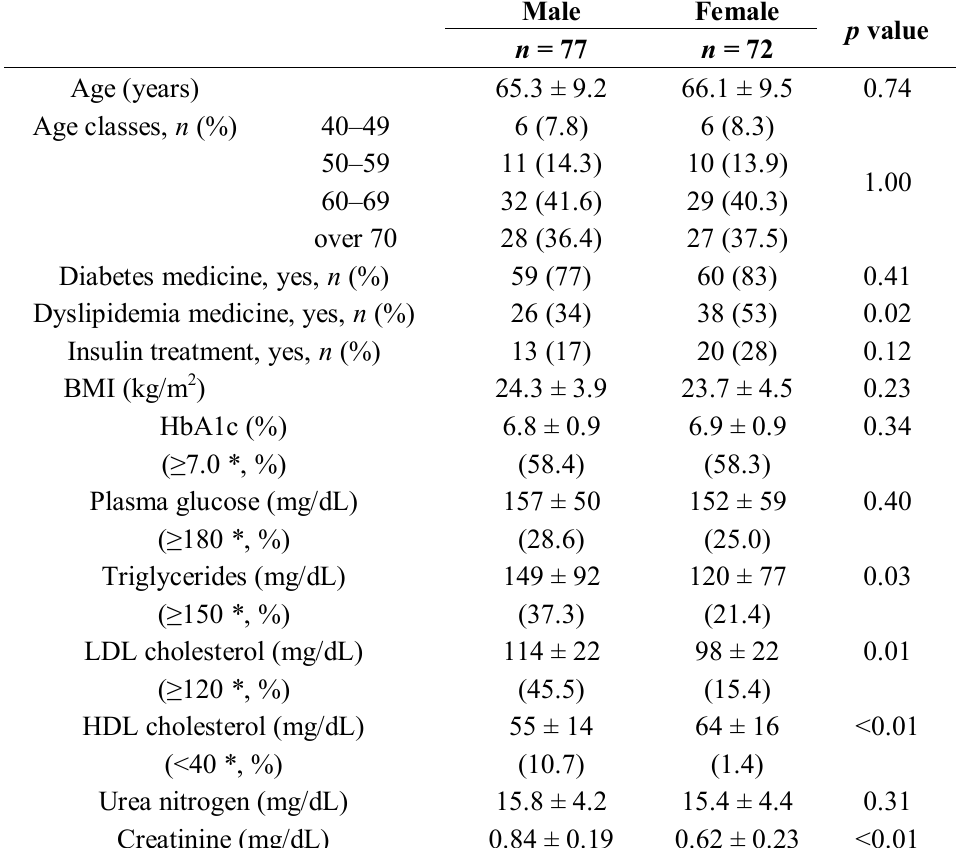
Table 1. Characteristics of type 2 diabetic mellitus (T2DM)